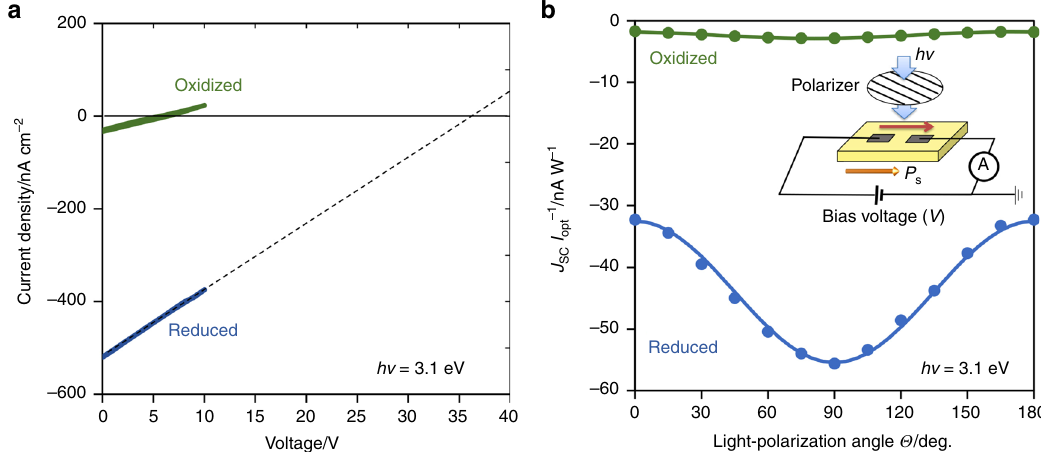
Fig. 7 PV current density ( J )-bias voltage ( V ) properties. The measurements were performed under light at a wavelength of 405 nm (photon energy hv of 3.1 eV) and an intensity of 5.6 W cm − 2 . The J – V properties at a light-polarization angle ( Θ ) of zero are presented in a , and the short-circuit current density ( J sc ) versus Θ is plotted in b along with the measurement system. The inset in b schematizes the measurement system. The direction of I opt is set at i = 1 and that of P s at i = 3. The light-polarization ( Θ ) is de fi ned as the angle between the polarization plane of light and the measured direction of J . In the con fi guration in the inset of b , the photocurrent is parallel to P s , and the current density is J 3 . The fi tting analysis of the J sc ( Θ ) data by the equation derived from the symmetry consideration provides the bulk PV tensor elements of β 31 and β 31 , as listed in Supplementary Table